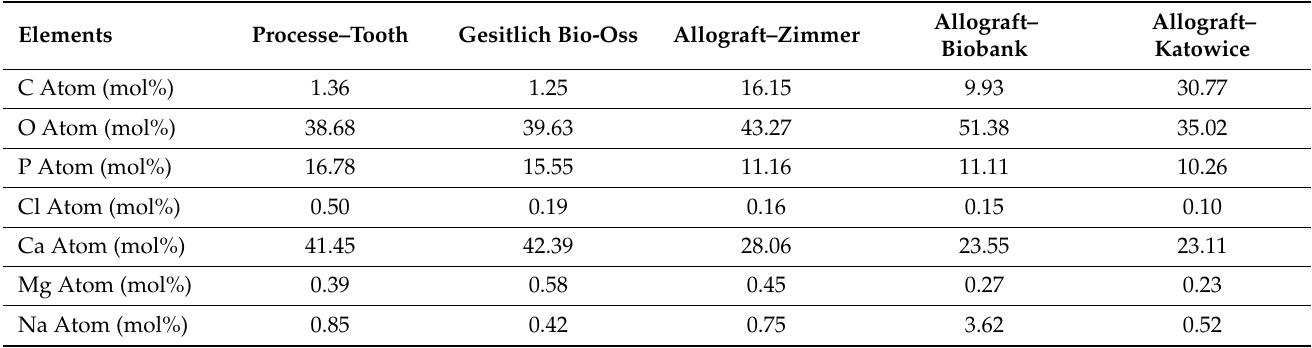
Table 1. The chemical composition of investigated bone-replacing materials (EDS